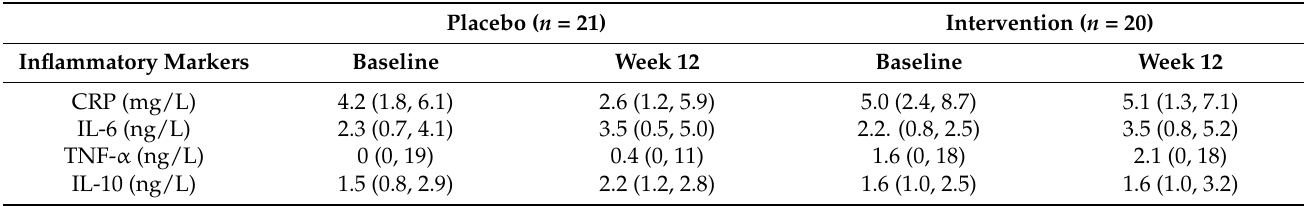
Table 2. Inflammatory biomarker concentrations at baseline and week